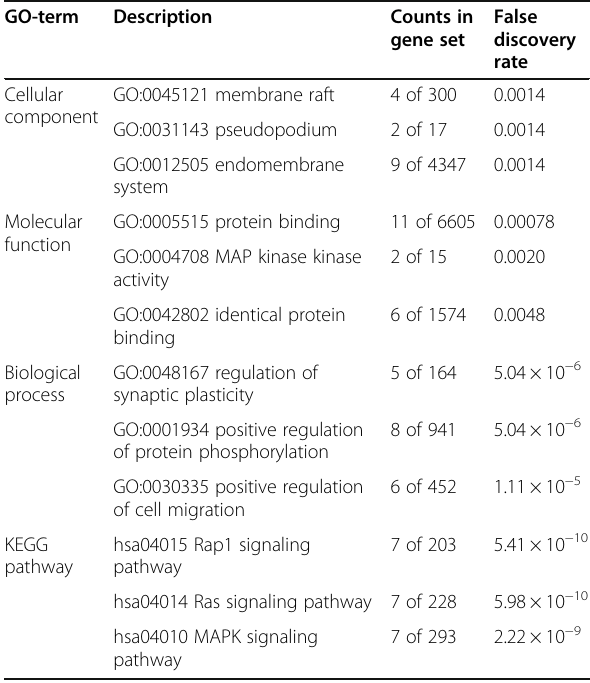
Table 3 Analysis of GO and KEGG pathways of ATP1A3 and